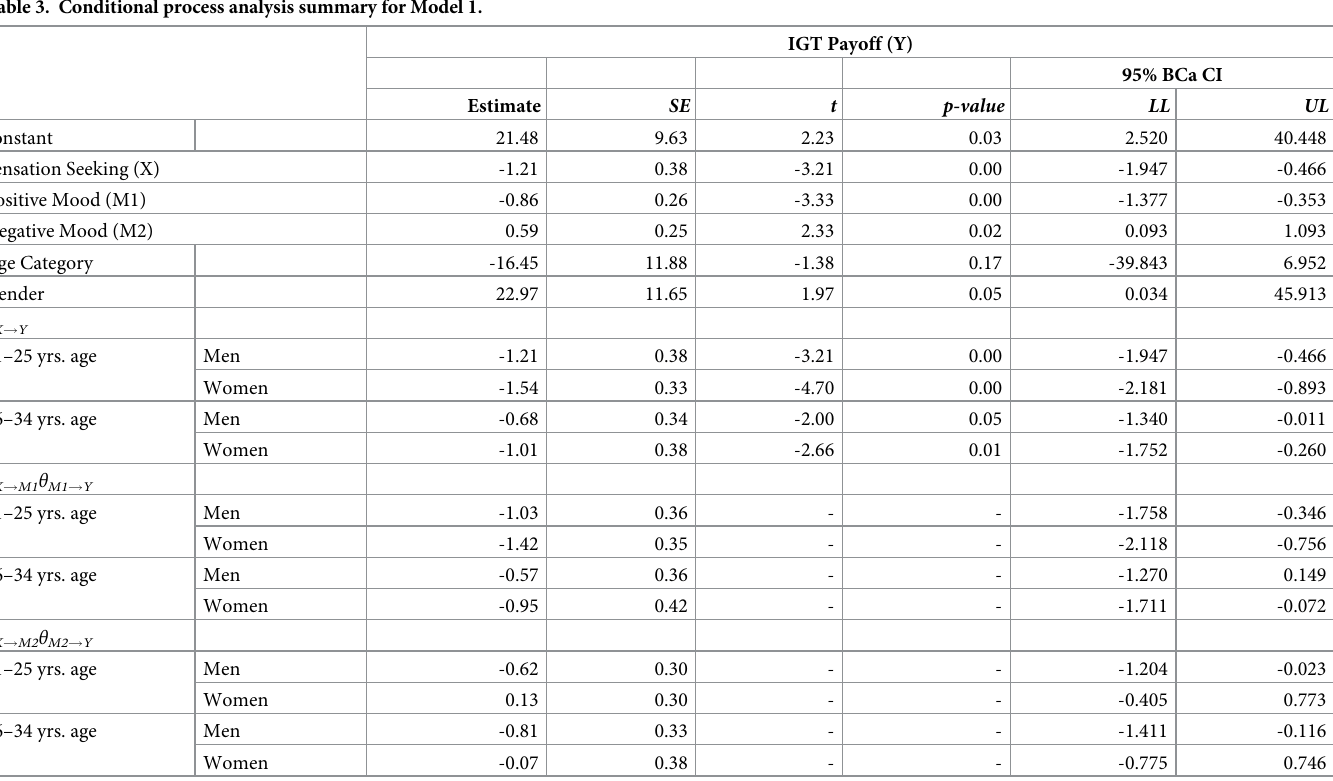
Table 3. Conditional process analysis summary for Model 1.